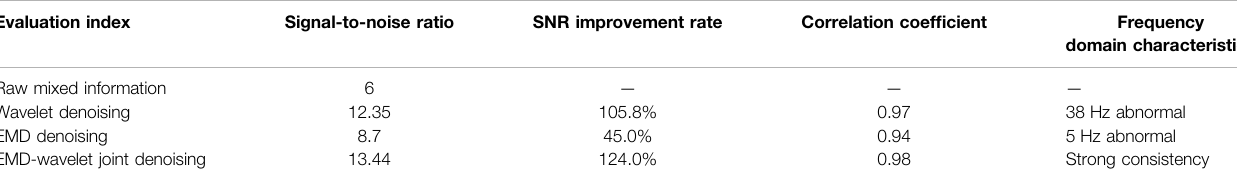
TABLE 1 | Comparison table of denoising effect by different denoising methods Evaluation